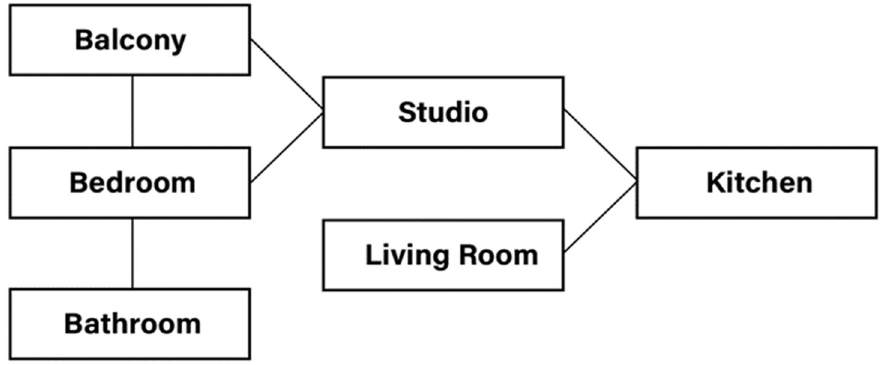
Figure 4. Section connectivity unweighted graph.